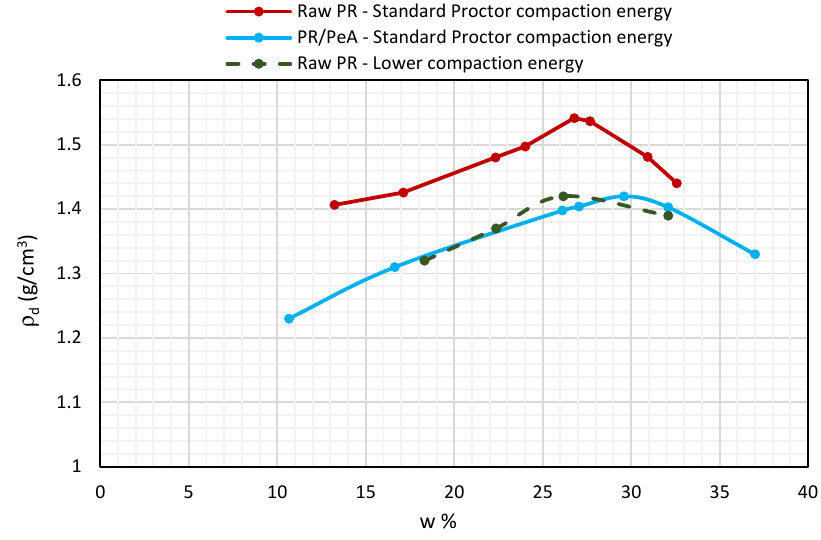
Figure 1. Compaction curves of PR soil and PR/Pea mixture.